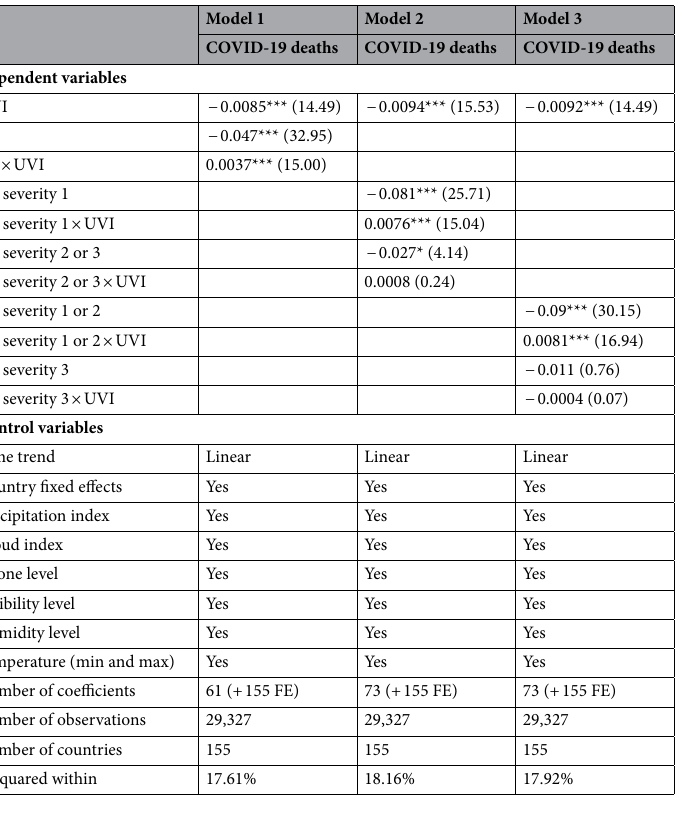
Table 3. Results of log-linear fixed-effects model. LD Lockdown severity. + : p < 0.10; *: p < 0.05; **: p < 0.01; ***: p < 0.001. F-statistic for long-run coefficients in